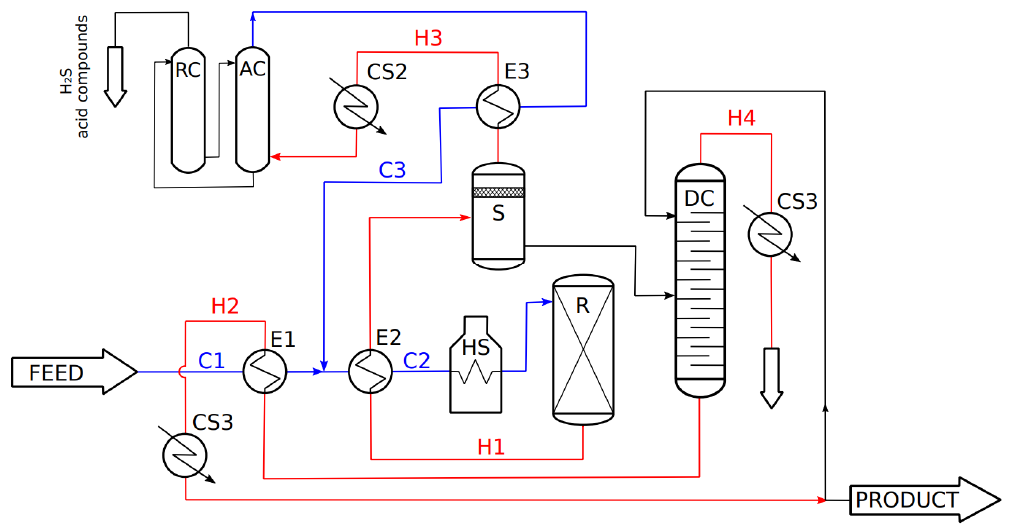
Figure 4. Current industrial plant for the hydrogenation of oil.